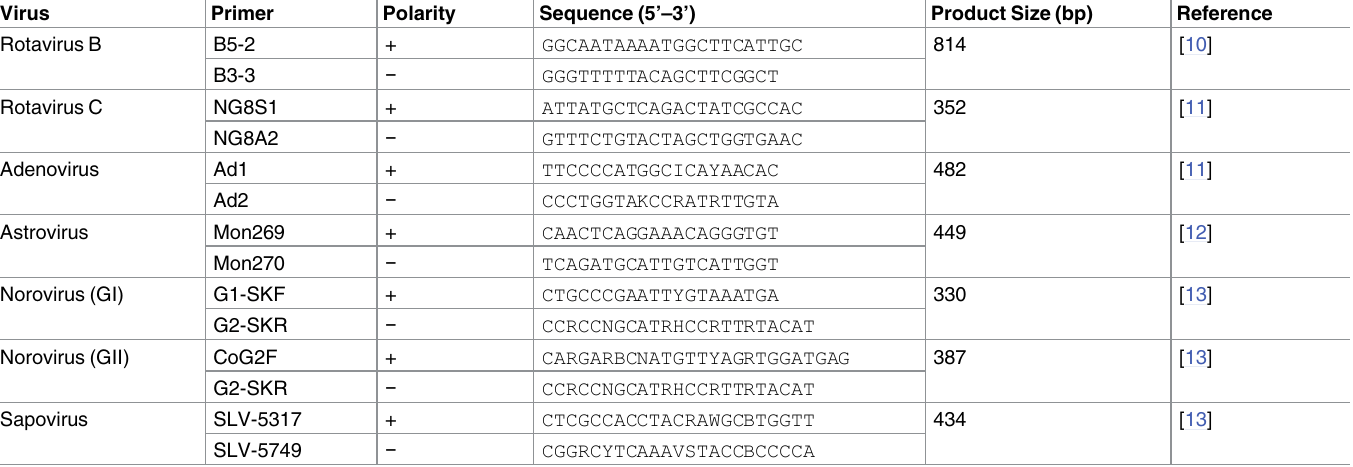
Table 1. Primers and sequence information used in multiplex PCR for viral